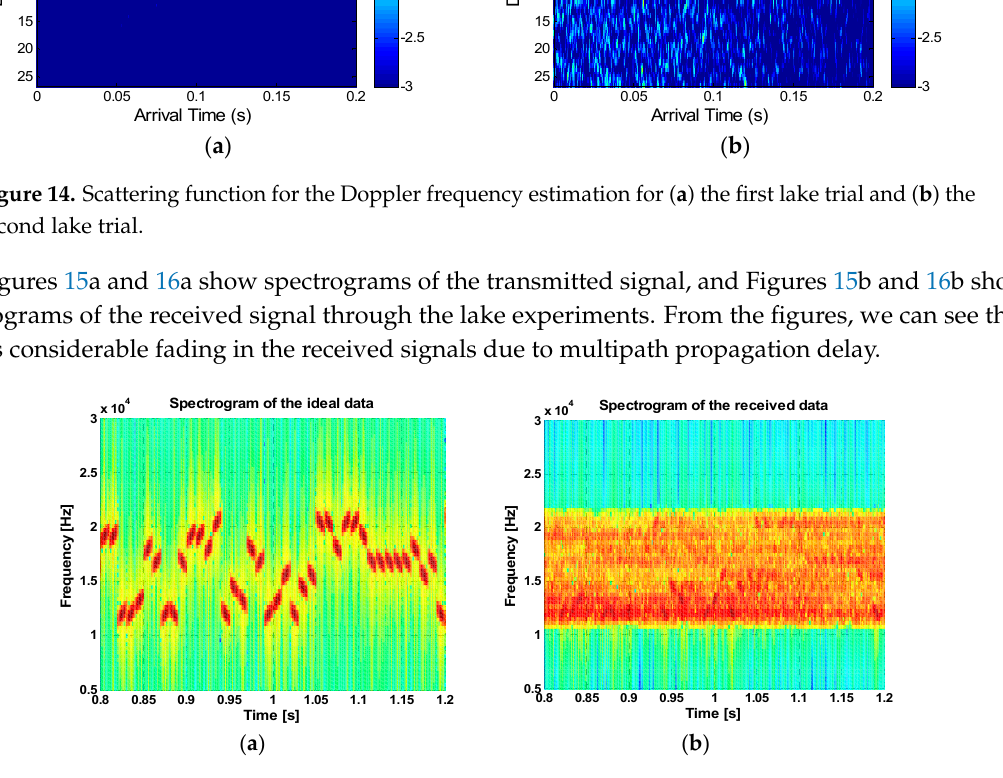
Figure 15. Spectrogram of ( a ) the transmitted signal, and ( b ) the received signal in the first trial.